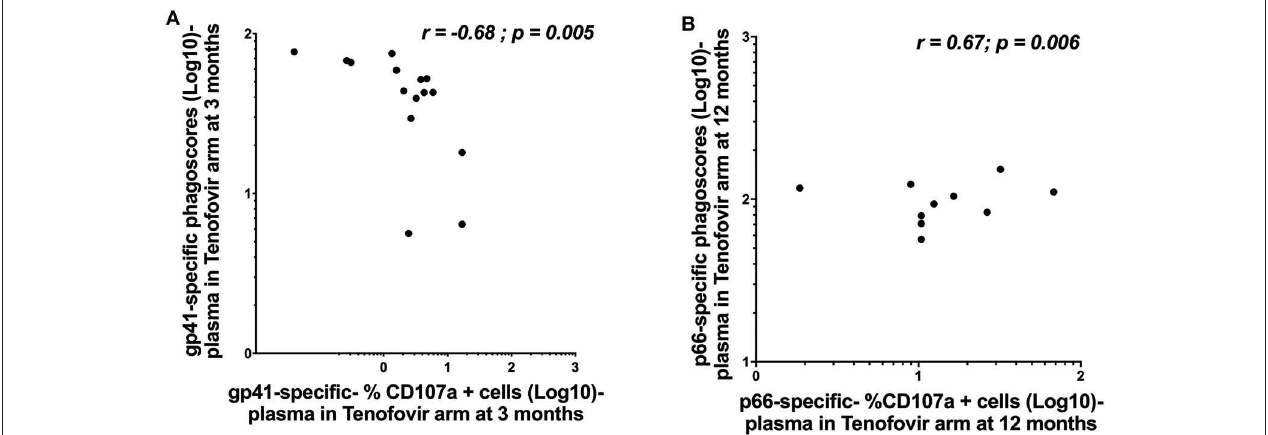
FIGURE 6 | Correlations between ADNP (Log 10 Phagoscores) and NK cell activated ADCC (antibody-specific- %CD107a + cells [Log10]) activities in the plasma of women in the tenofovir arm. (A) gp41-specific- phagoscores (Log10) at 3 months in the tenofovir arm, (B) p66-specific- %CD107a + cells (Log10) at 12 months. Spearman R correlation analyses were performed. Significant values were identified as p < 0.05.